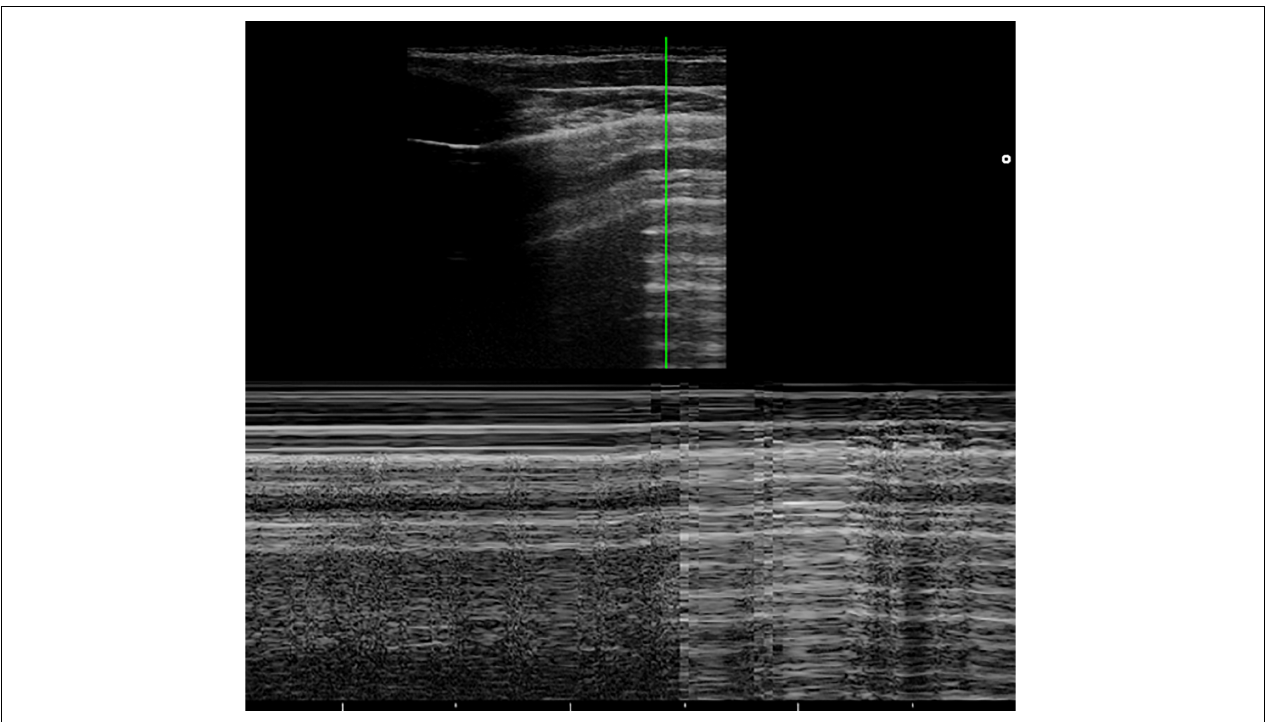
FIGURE 2 | The grayscale lung ultrasound examination (transverse scan between the intercostal fields; linear probe with a frequency of 12 MHz) of a 15-year-old boy with left apical pneumothorax shows the Barcode sign identified in M-mode as a transition from the normal lung ( linear granular pattern on the right of the figure ) to the pneumothorax ( linear pattern on the left of the figure ). The grayscale lung ultrasound examination (transverse scan between the intercostal fields; linear probe with a frequency of 12 MHz) of a 16-year-old boy with right apical pneumothorax, shows the Lung Point sign identified in B-mode as the point where normal sliding disappears due to the presence of air in the pleural